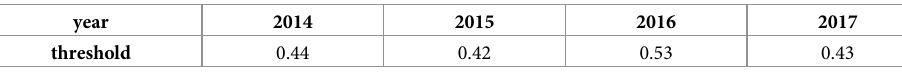
Table 2. Optimal thresholds in